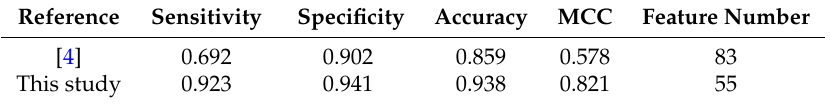
Table 7. Performance comparison with the existing methods on the independent testing